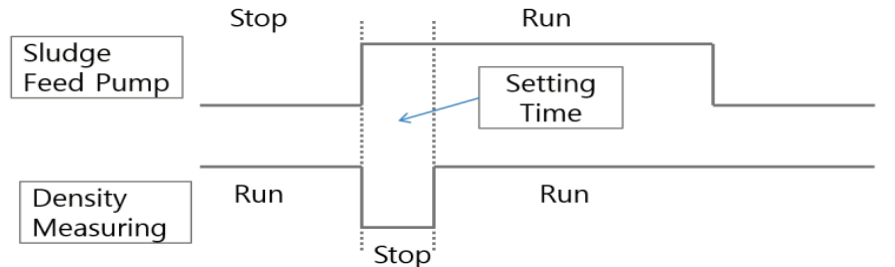
Figure 4. Delay of the density